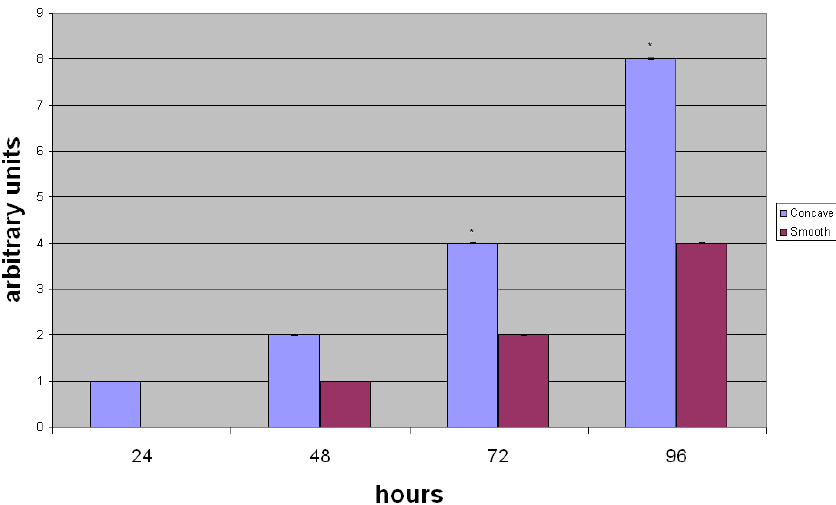
Figure 3. Alkaline phosphatase detection during cell differentiation. The image shows the quantity of ALP during osteoblast differentiation at 24, 48, 72 and 96 hours within the cells cultured on the different surfaces. The data have been rounded to the closest integer value. The error bars are